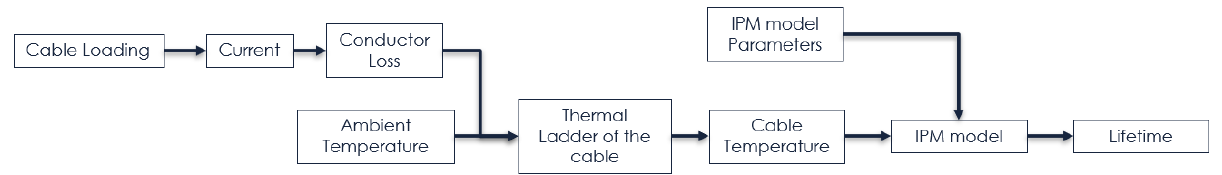
Figure 1. Thermal aging model for cable lifetime estimation.